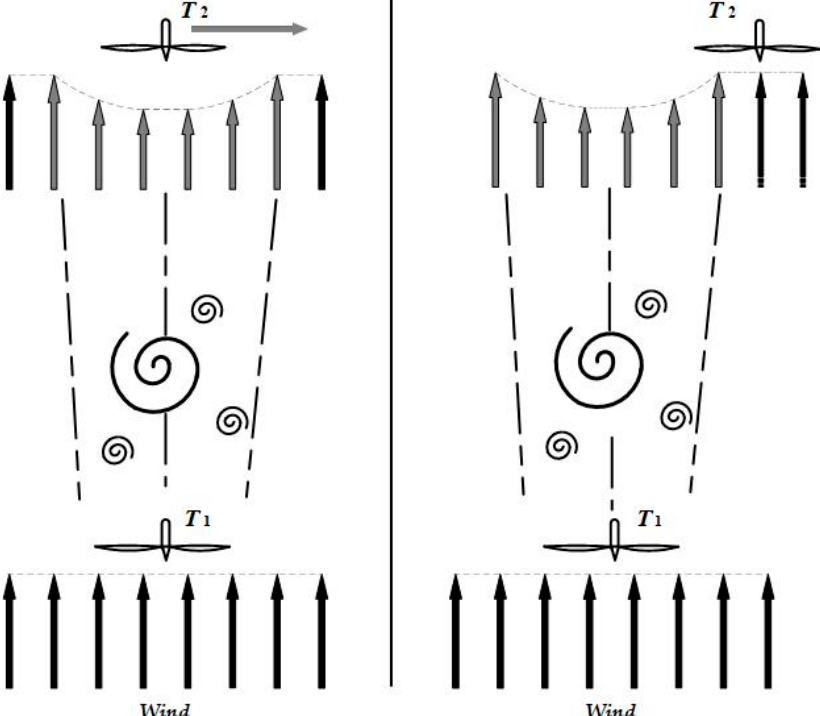
Figure 5. Control diagram of repositioning.